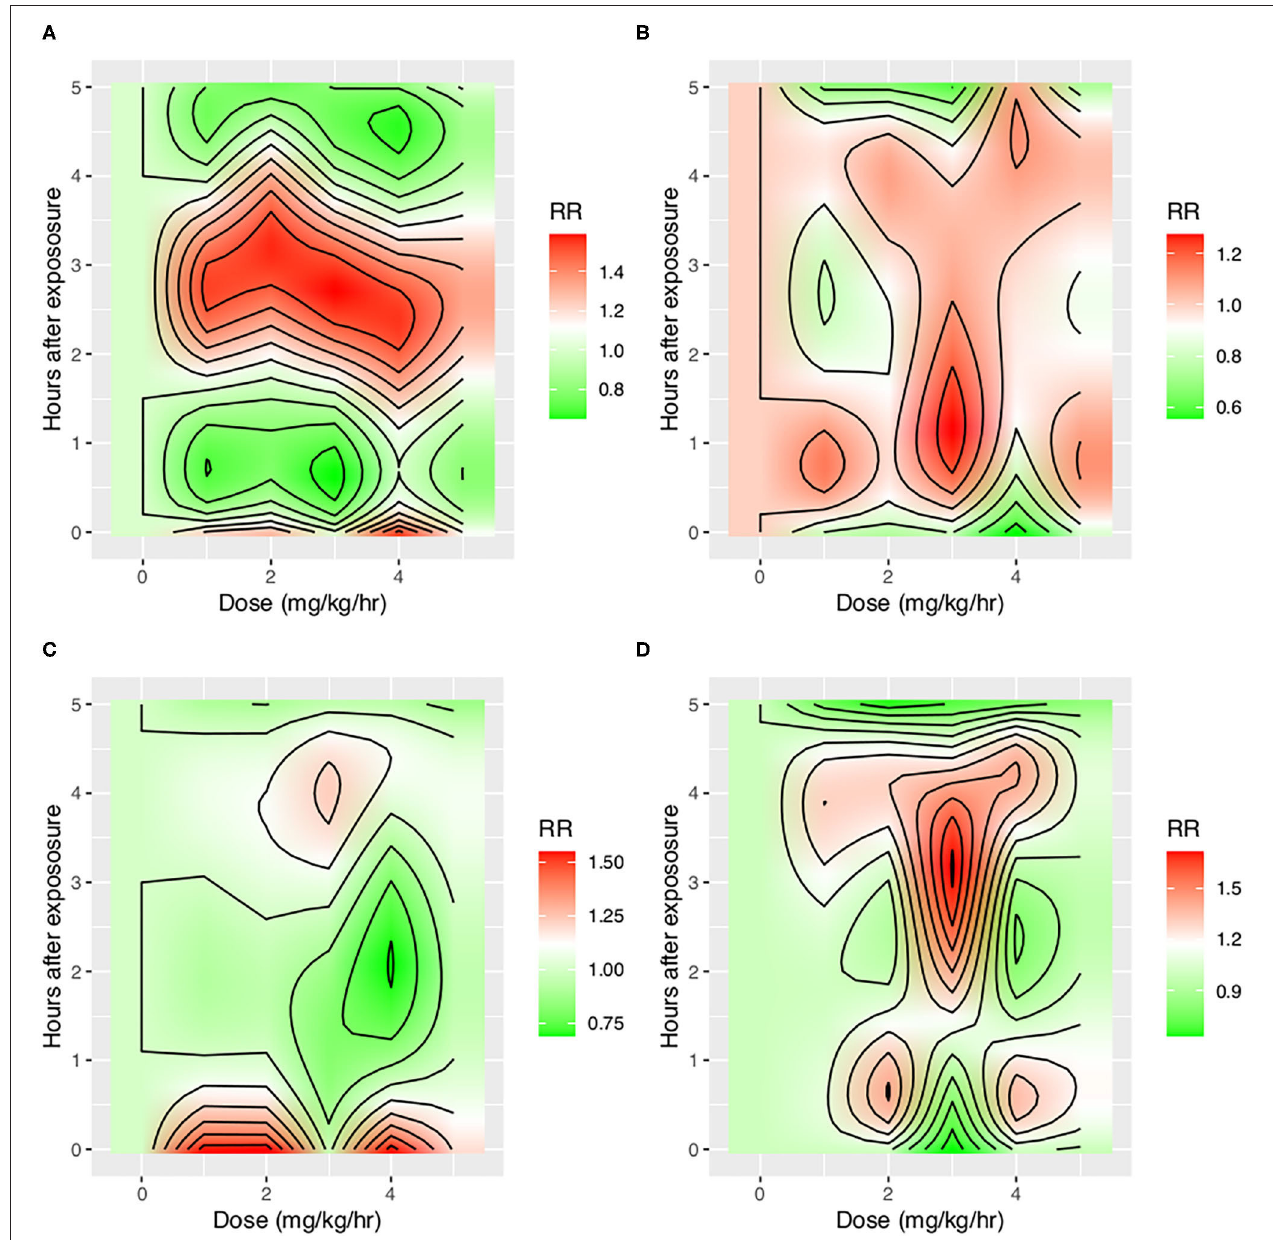
FIGURE 4 | Impact of propofol on four types of asynchrony. Propofol was entered into the distributed lag non-linear model with two dimensions: dose and time lag. The y-axis shows the time after instantaneous exposure of propofol, so the drug was assumed to be discontinued after a certain dose exposure. Other covariates including tidal volume, WOB, PEEP, plateau pressure, mode of ventilation, and day hours were adjusted. The red color shows increased risk of asynchrony, and the green color shows reduced risk of asynchrony. (A) Impact on DT, (B) Impact on IEE, (C) Impact on PC, and (D) Impact on SC. IEE, ineffective effort; DT, double triggering; SC, short cycling; PC, prolonged cycling.